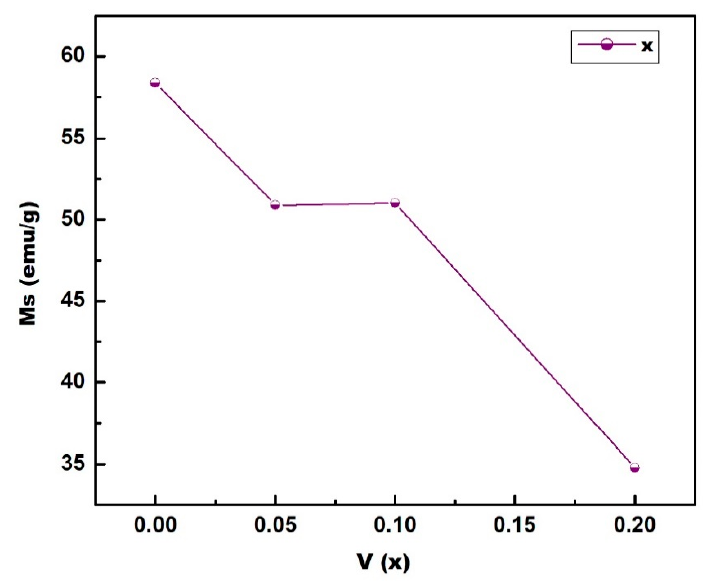
Figure 8. The change in Ms with change in V-doping level. Table 3. Ferromagnetic parameters: saturation magnetization M s (emu/g), Remnant